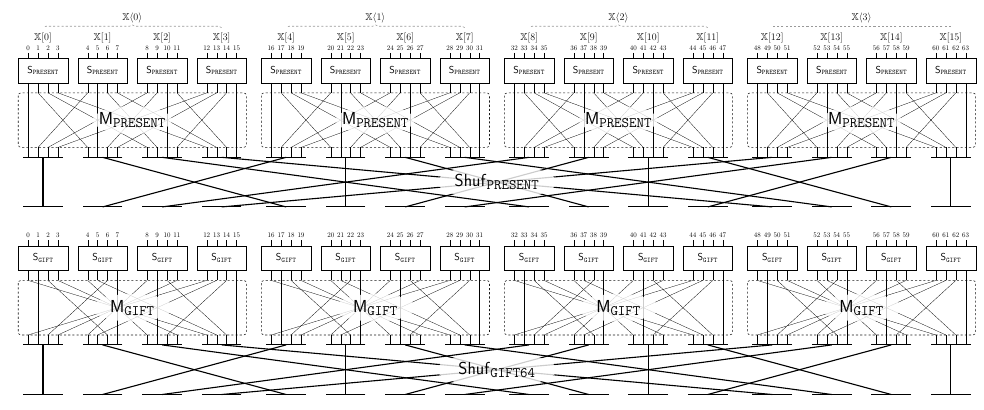
Figure 2: PRESENT and GIFT-64 ’s round